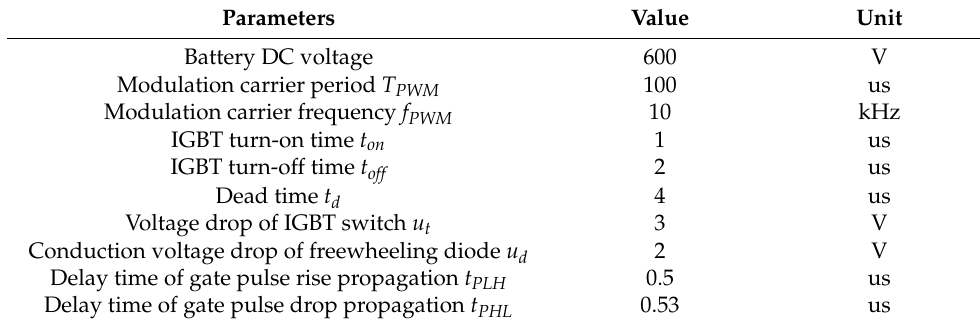
Table 3. Parameters of the inverter.